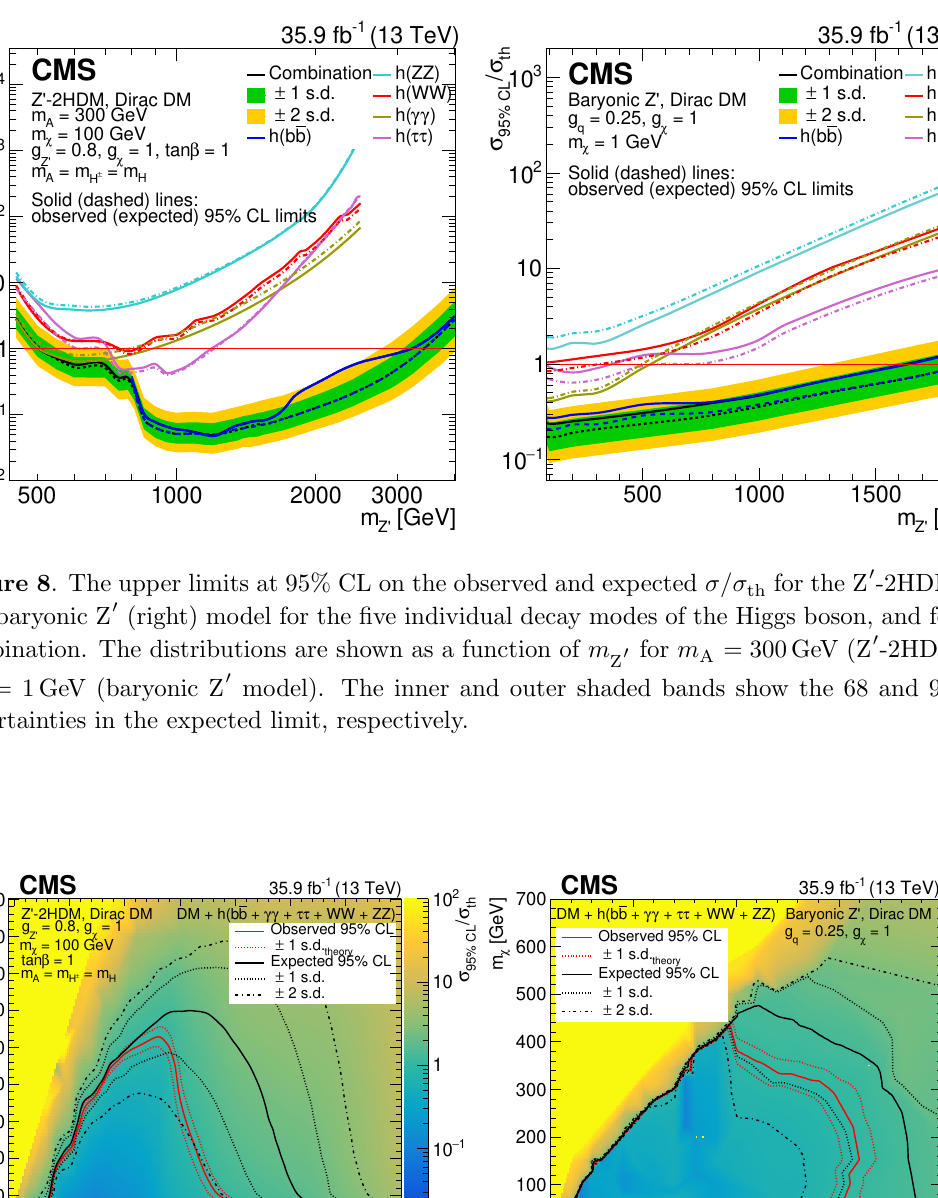
in the m { m and th A Z 0 = 0 : 8, g = 1, tan (cid:12) = 1, m = 100 GeV, and (cid:31) (cid:31) Z 0 = 1, g = 0 : 25 for the baryonic Z 0 (cid:31) q